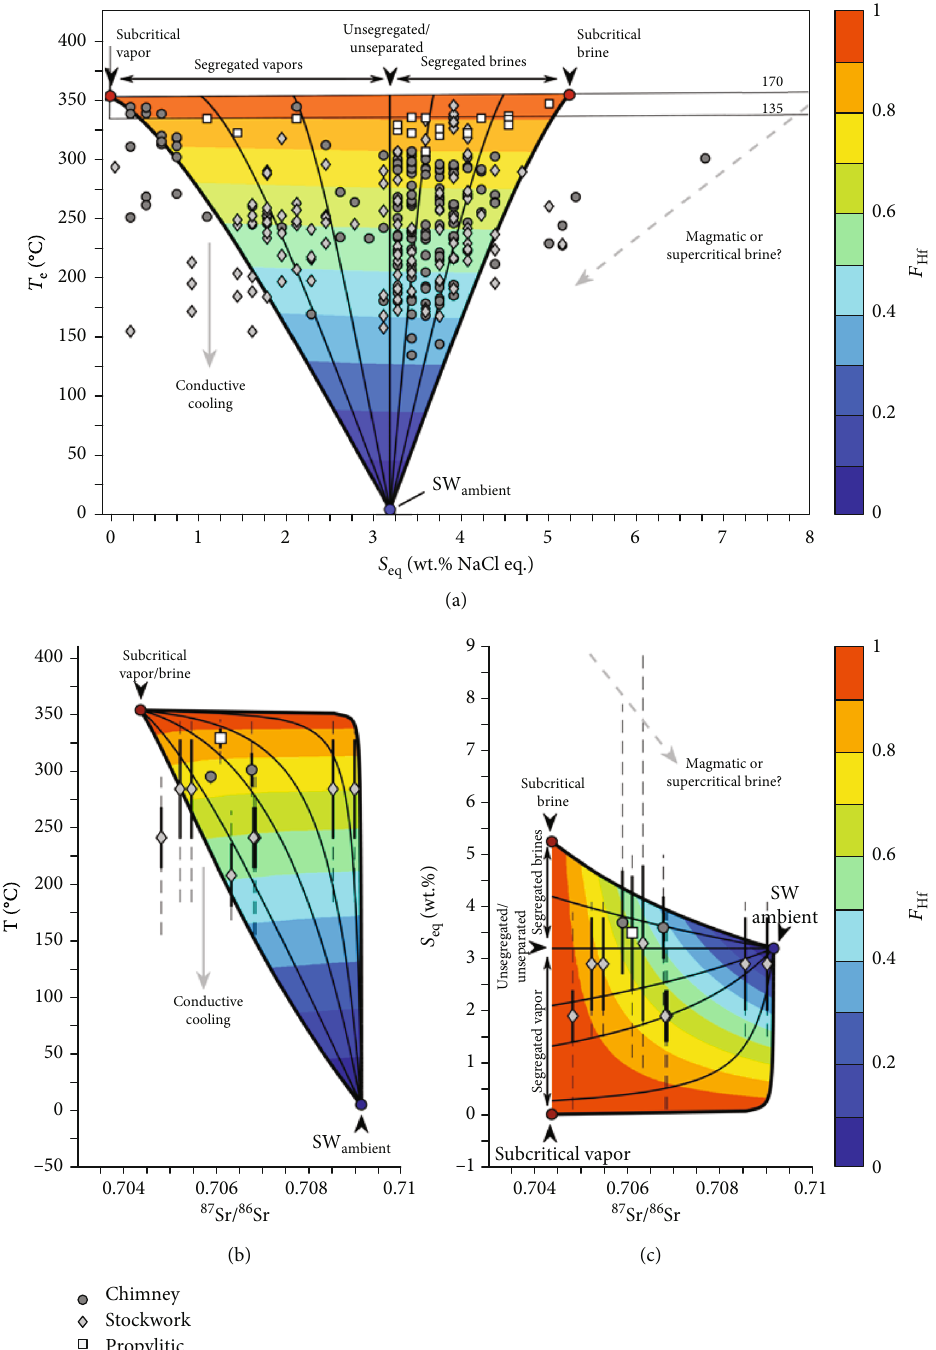
Figure 9: Mixing model 1. (a) Salinity-temperature relation for isenthalpic mixing paths of mixtures between phase-separated hydrothermal fl uids and ambient seawater at 170 bar. Thin black horizontal curves represent isobaric V+L curves at 135 and 170 bar (calculated after Driesner and Heinrich [57]). The thick black curves denote isenthalpic mixing of the chosen brine-vapor pair. The thin lines represent fl uids derived from phase segregation of the phase-separated brine and vapor. The color code gives the mass fraction of the hydrothermal fl uid F in the mix (i.e., F = 1 pure hydrothermal fl uid to F = 0 pure seawater). (b) Relationship between temperature and 87 Sr/ 86 Sr Hf Hf Hf for mixing model 1. Vertical lines represent the natural variability of inclusion data in S and T (dashed lines: min to max, thick lines: eq e mean ± SD ). Note how low-saline high-temperature fl uids can precipitate sulfate with near seawater 87 Sr/ 86 Sr. (c) Relationship between salinity and 87 / 86 Sr for the mixing